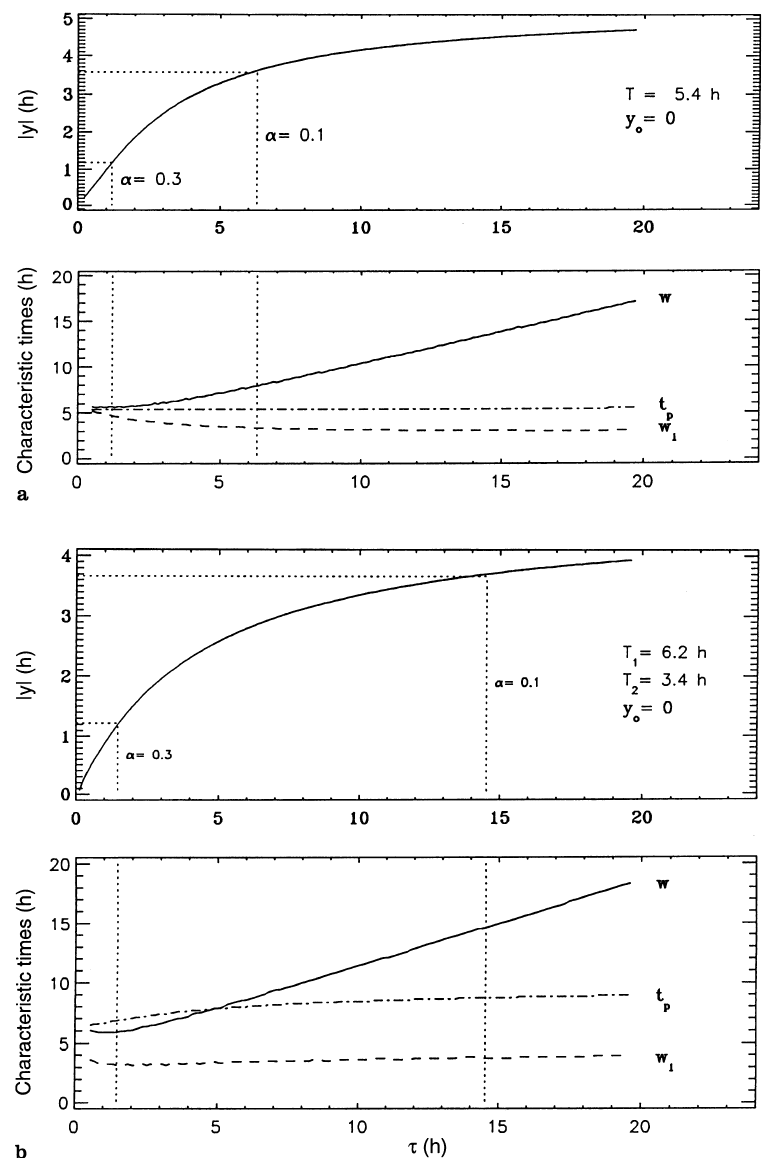
Fig. 5. a Like Fig. 2, this figure shows the variation of j y (cid:133) s (cid:134)j (cid:136) j D p (cid:133) s (cid:134) = Q o j ( upper panel ) and characteristic times ( lower panel ) as functions of s ; but for a rectangular input function, with T (cid:136) 5 : 4 h (see Fig. 4a and Table 1). The horizontal dotted lines of the upper panel correspond to y =3.57 and y =1.19 derived for this event (Eq. 9), when a (cid:136) 0 : 1 and a (cid:136) 0 : 3 respectively. The inter-sec- tions of these lines with the curve j y (cid:133) s (cid:134)j give the roots s =6.3 h and s =1.2 h. The inference of the corresponding characteristic times can be made from the curves of the lower panel. The practical meaning of this inference is discussed in Sect. 3 (see Table 2) b Similar to a but for event 2. The curves for this case are derived from the triangu- lar approximation adopted for this event, with T 1 (cid:136) 6 : 2 h and T 2 (cid:136) 3 : 4 h (see Fig 4b and Table 1). For a (cid:136) 0 : 1 and a (cid:136) 0 : 3 the respective roots found for the delay time are s (cid:136) 14 h and s (cid:136) 1 : 5 h (see